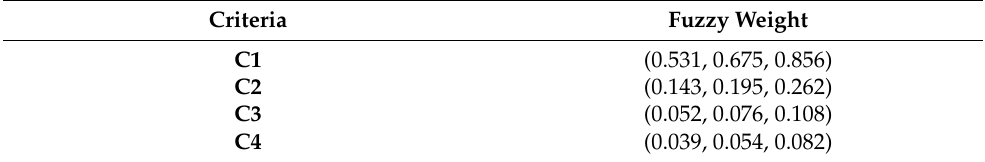
Table 11. Main criteria fuzzy